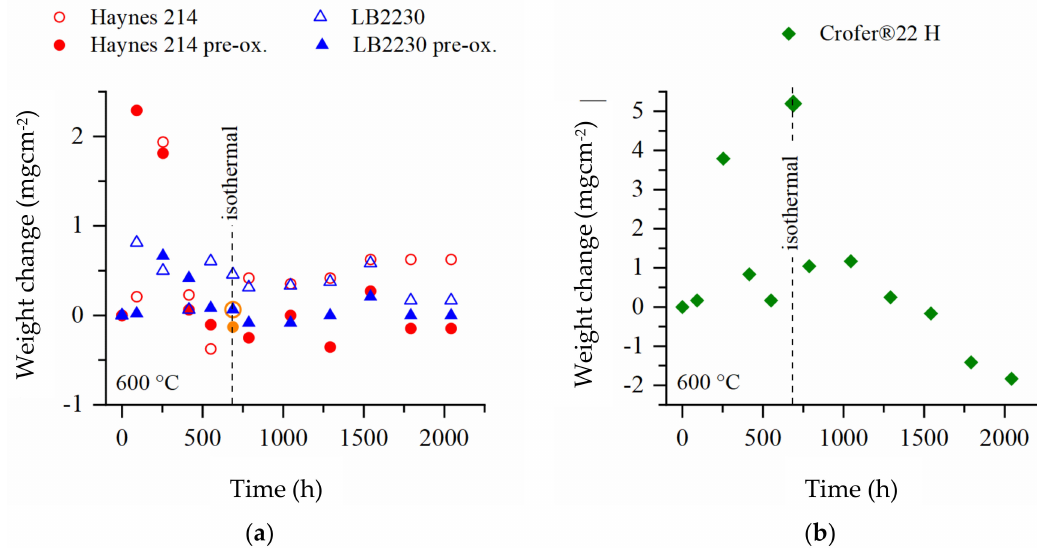
Figure 3. Weight changes of corrosion specimens during annealing in solar salt at 600 ◦ C (discontinuously performed by FZ Jülich, IEK-2; isothermally by DLR): ( a ) Al 2 O 3 -formers and ( b ) Cr 2 O 3 -formers (mean values of 2 specimens in case of discontinuous testing, single value in case of continuous